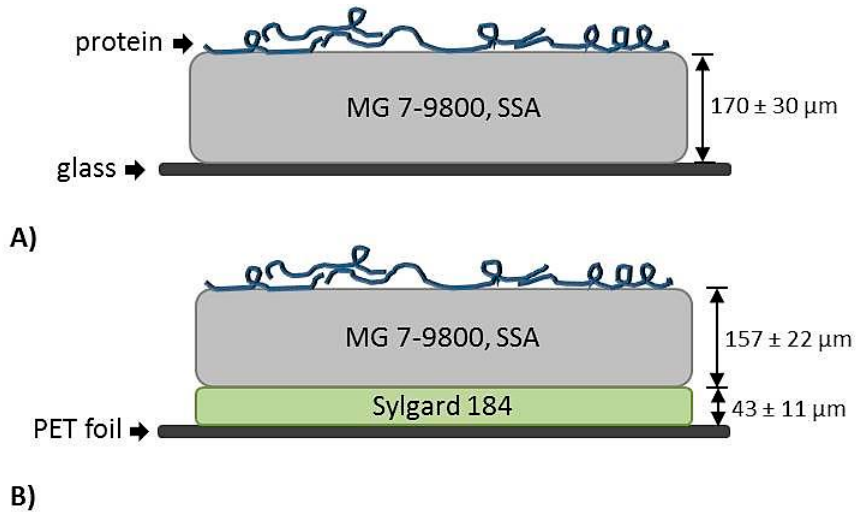
Figure 1. Schematic representation of the polymeric samples: soft skin adhesive (SSA) MG 7-9800 was applied on a glass surface ( A ) or manufactured as a composite film on a PET foil ( B ).